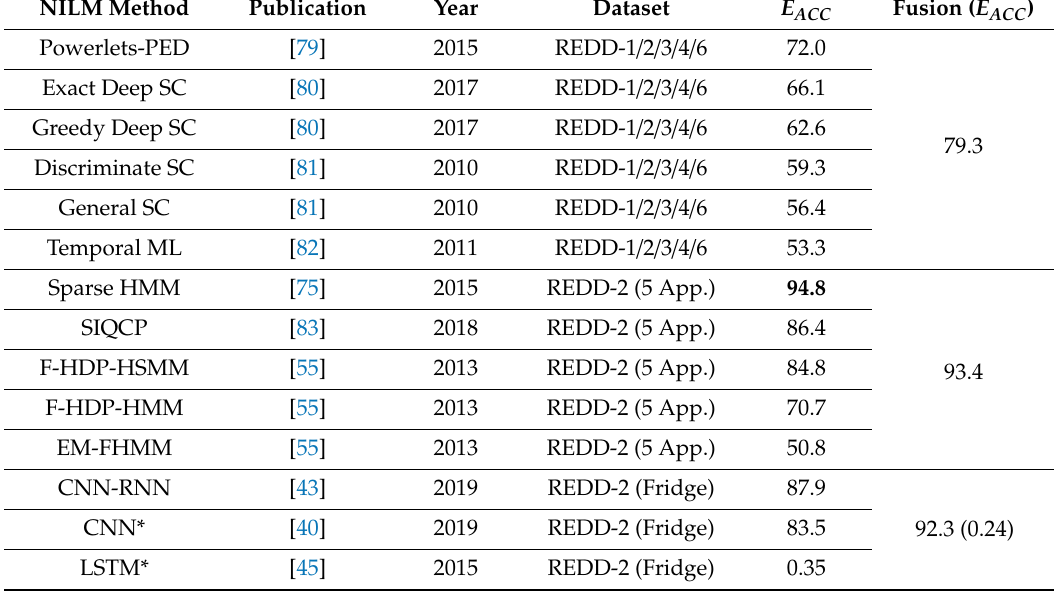
Table 6. Comparison of E ACC (%) values for recently proposed NILM methodologies (methods marked with an asterisk are not directly comparable because of a dataset transferability set-up used in [40] and a slight change in the accuracy metric in